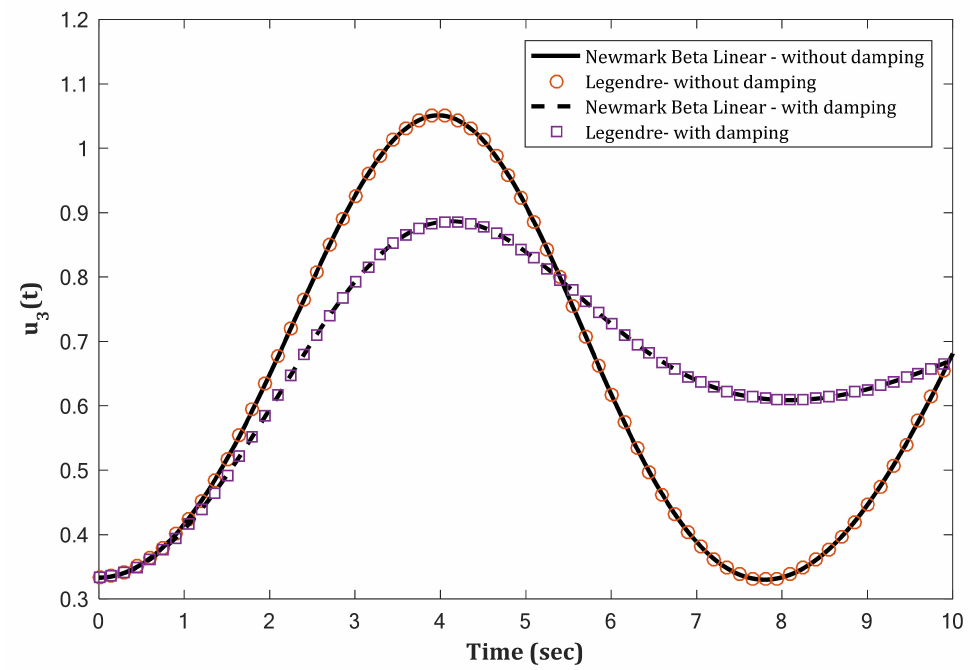
Figure 9. Free vibration analysis of a 3DOF system. Comparison of u 3 ( t ) as a function of time, as obtained using the LGM method or the linear Newmark- β